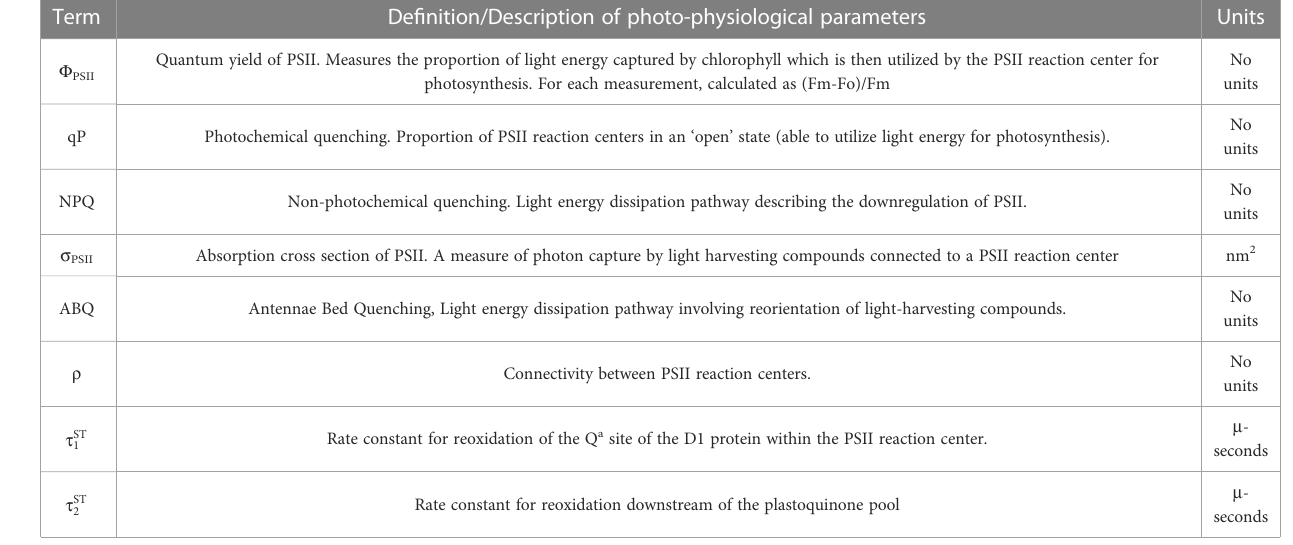
TABLE 1 Table of photo-physiological parameters, units, and de fi nitions/descriptions. Term De fi nition/Description of photo-physiological